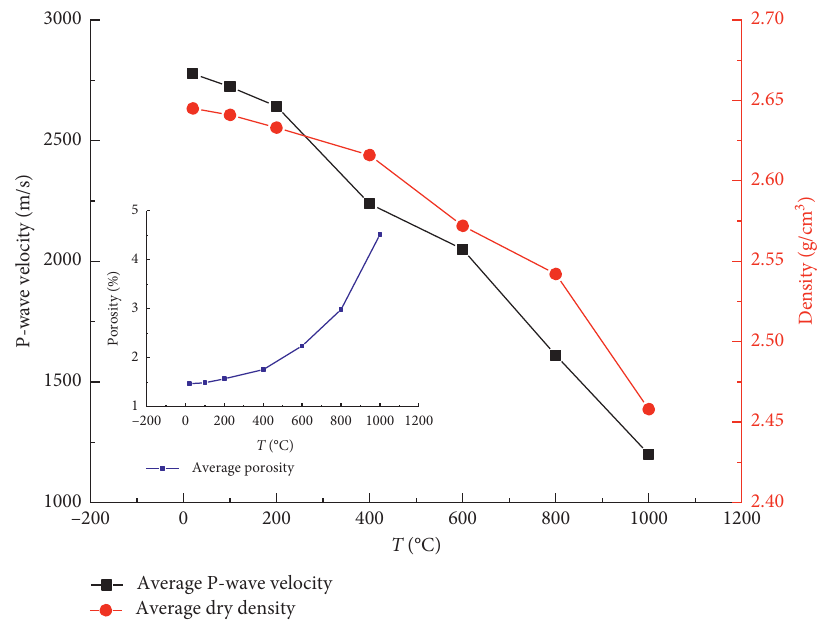
Figure 4: Variation in P-wave velocity, dry density, and porosity with high